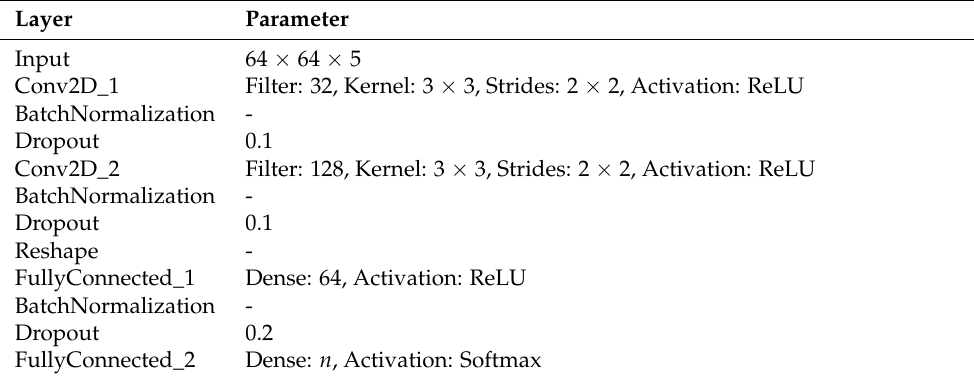
Table 2. Architecture of the used